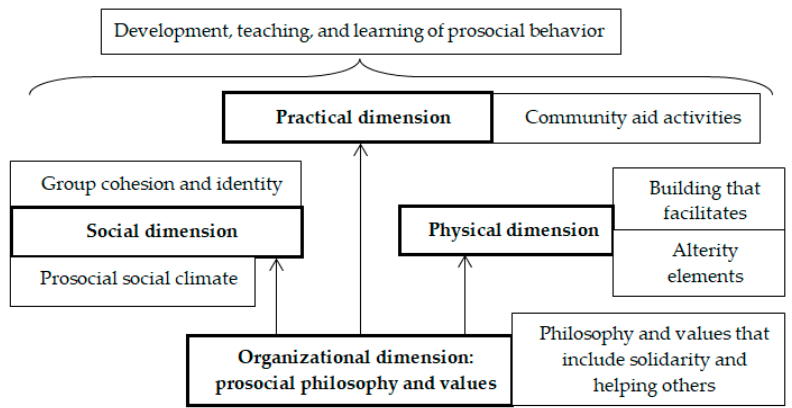
Figure 1. Axial coding: microstructural conditions of the development, teaching, and learning of prosocial behavior.